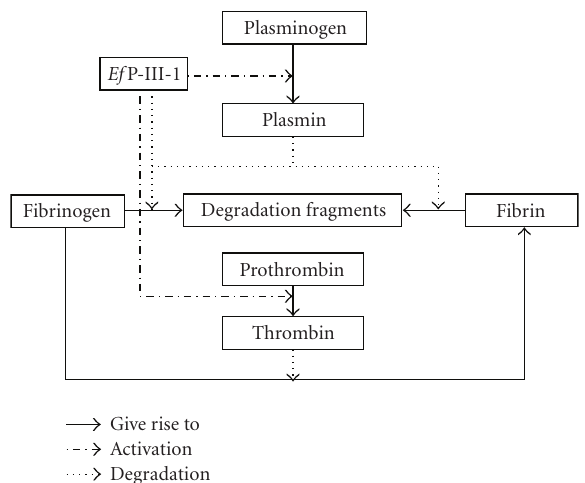
Figure 5: Roles of Ef P-III-1 in procoagulation and anticoagulation Activation is indicated by dashed lines, and degradation is indicated by dotted lines (see